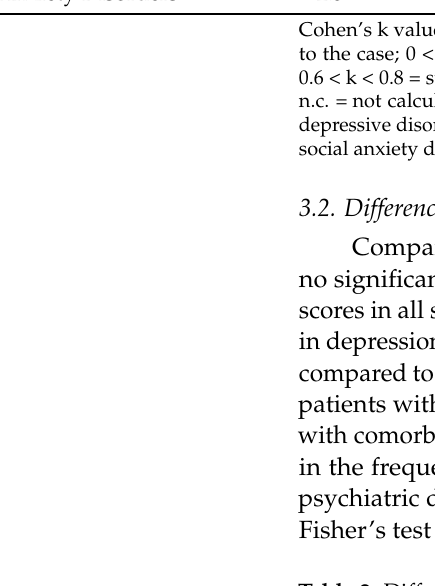
Table 2. Differences between patients with and without comorbidity according to